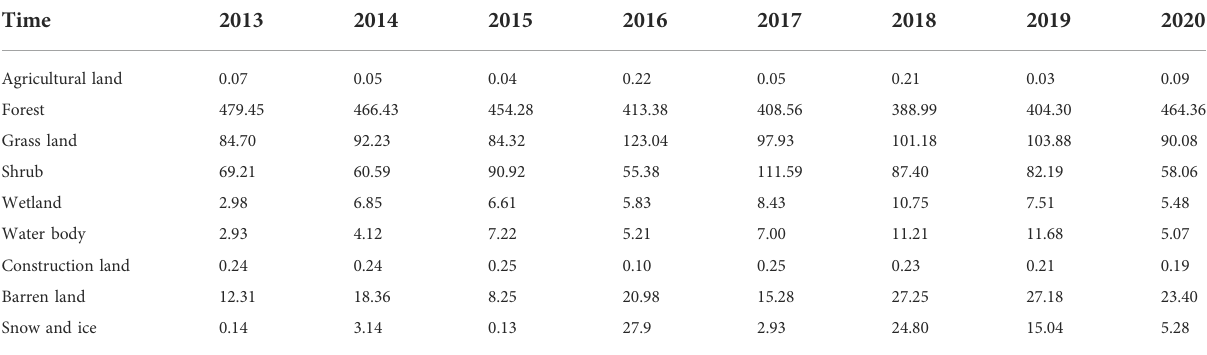
TABLE 7 Change of land cover area in Jiuzhaigou (km 2